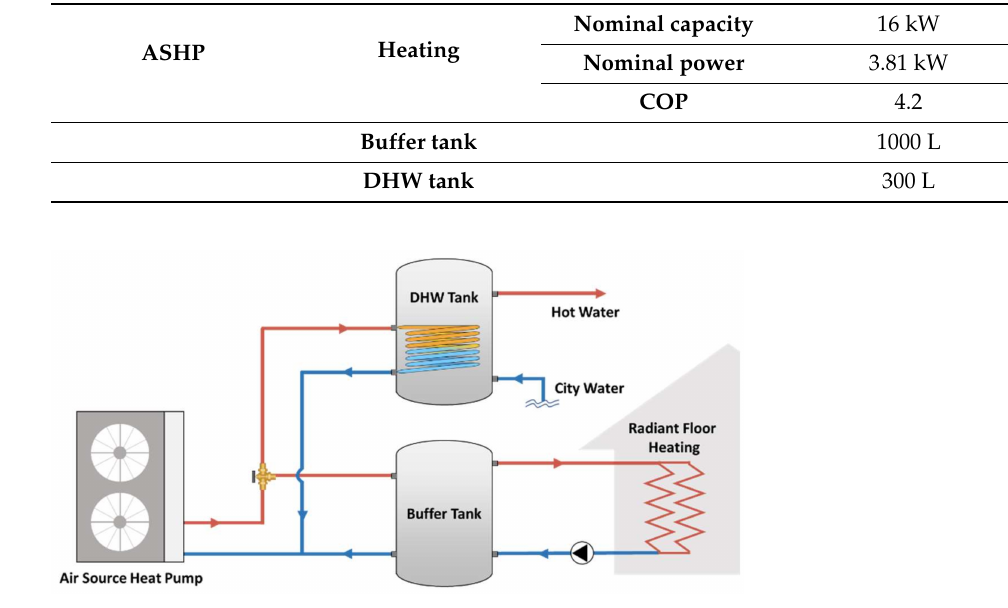
Table 2. Specification of space heating and domestic hot water system.